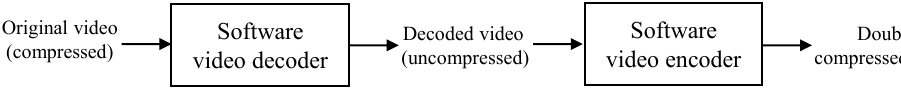
Figure 5. Validation method of the proposed